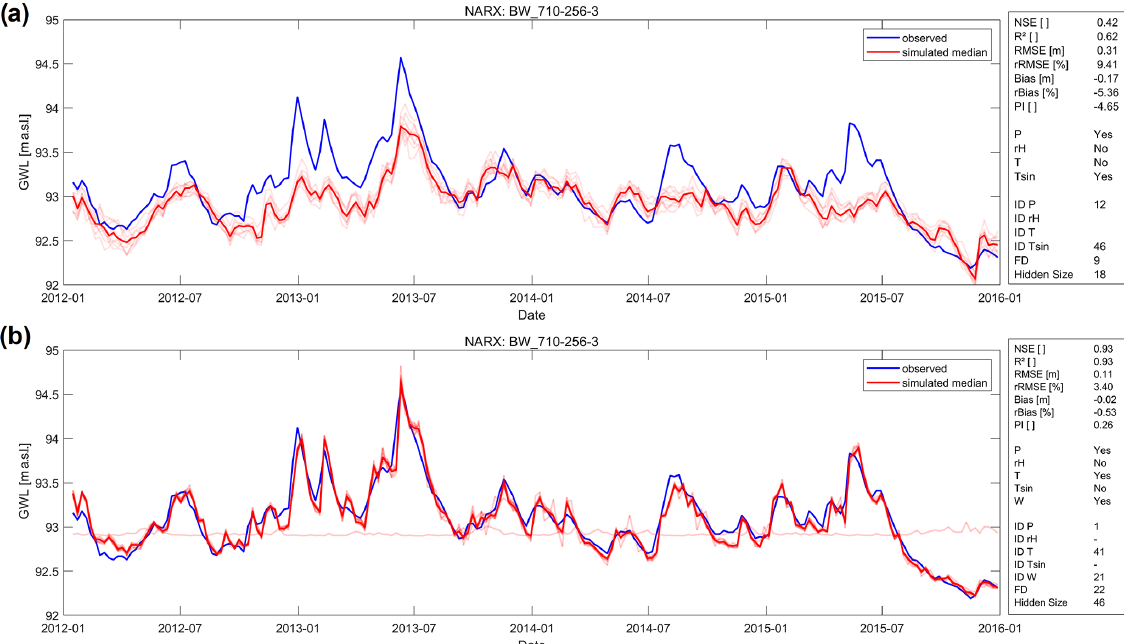
Figure 6. Forecasting performance exemplarily shown for NARX model of well BW_710-256-3 (a) based on meteorological input variables and (b) improved performance after including the Rhine water level ( W ) as input variable.